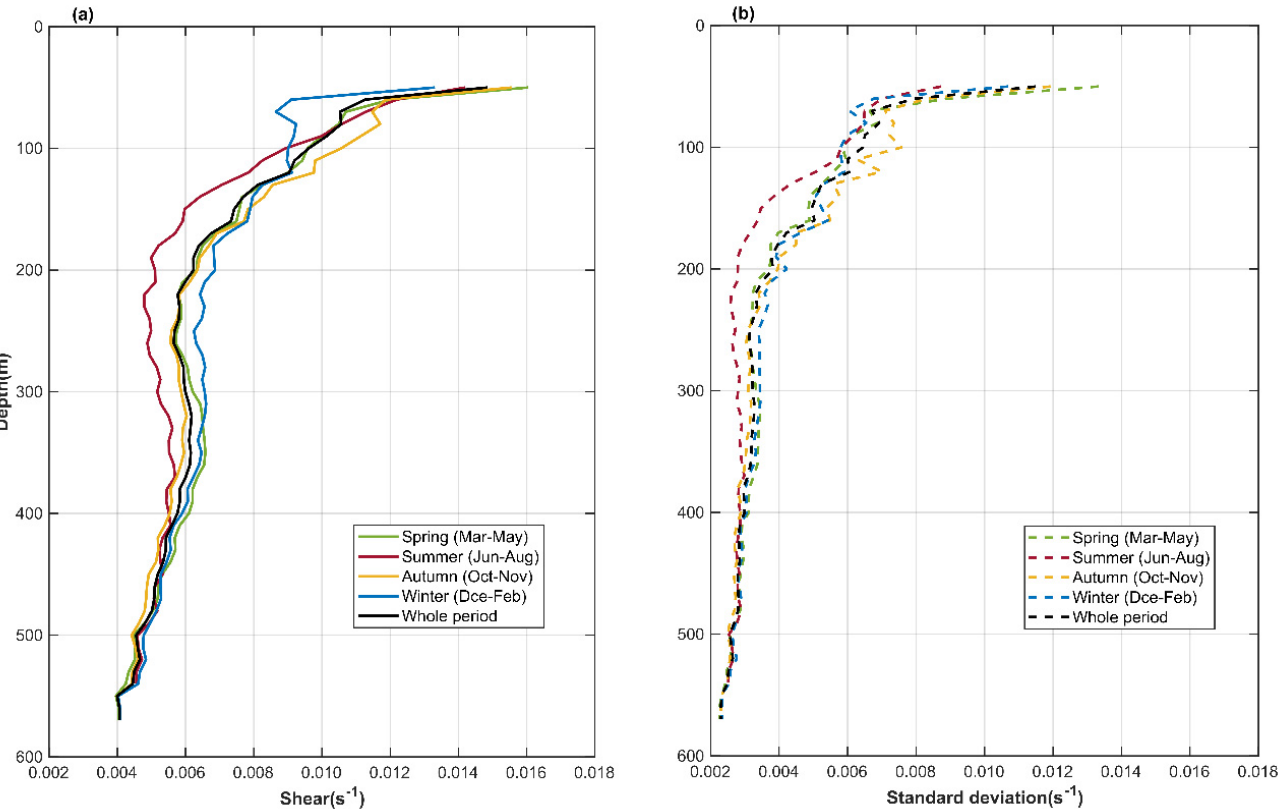
Figure 4. Vertical profiles of seasonal mean total shear ( a ) and its corresponding standard deviations ( b ). The black solid and dashed lines indicate the whole observation period. Figure 5 illustrates the climatological monthly depth-averaged total shear. There exists an evident seasonal variation of the depth-averaged (50–570 m) total shear (Figure 5a). Higher total shear occurs in late autumn to mid-spring (October to April), and lower total shear appears in summer (June to August). The largest and smallest total shear are found in March and July, respectively. The Kuroshio mainstream that meandered and intruded into the ECS northeast of Taiwan might be related to the seasonal variation of the total shear, since the Kuroshio mainstream moves seaward (shoreward) in summer (winter), with the eastern (western) invasion dominating [14,15,44], and the mooring station will not be (will be) affected by it. Furthermore, the vertical distributions of the mean total shear for the four seasons demonstrate different trends in their intensities over and under 200 m, as analyzed above. Therefore, the depth-averaged total shear values from 50 m to 200 m and 210 m to 570 m are also presented in Figure 5b,c, respectively. The result clearly reveals that they have different seasonal variation characteristics. For the former, stronger total shear occurs in spring (March to May) and autumn (September to November), and summer and winter (December to February) have weaker total shear, suggesting a semi-annual cycle. However, for the latter, the total shear displays a trend of decreasing first and then increasing, with the maximum and minimum values being found in January and July, respectively. The smallest total shear appearing in summer is a common point for